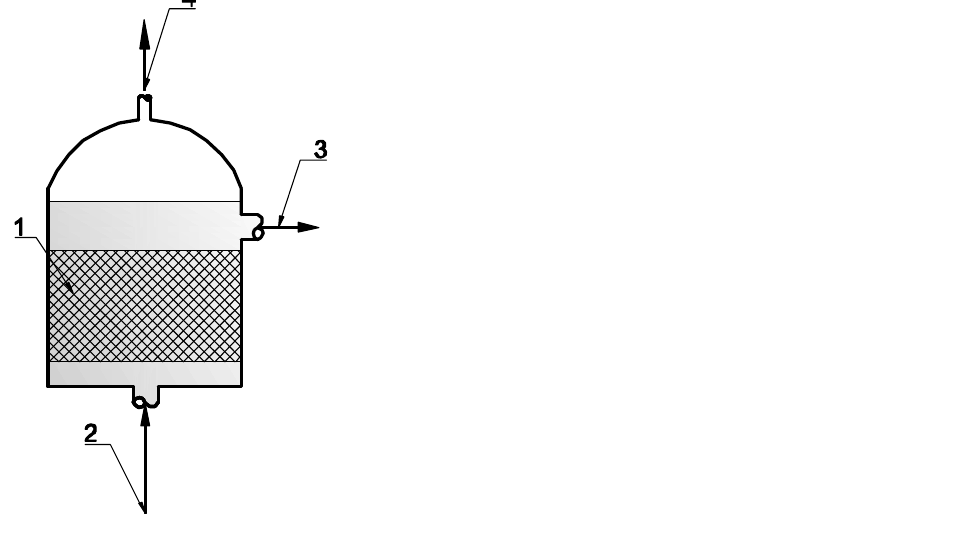
Figure 5. Diagram of an anaerobic biofilter: 1—biofilm bed, 2—raw wastewater, 3—treated effluent, 4—biogas.